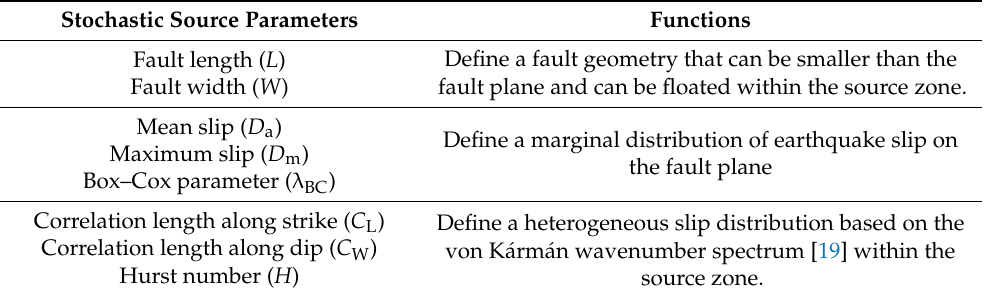
Table 2. Stochastic source parameters and associated functions in generating slip